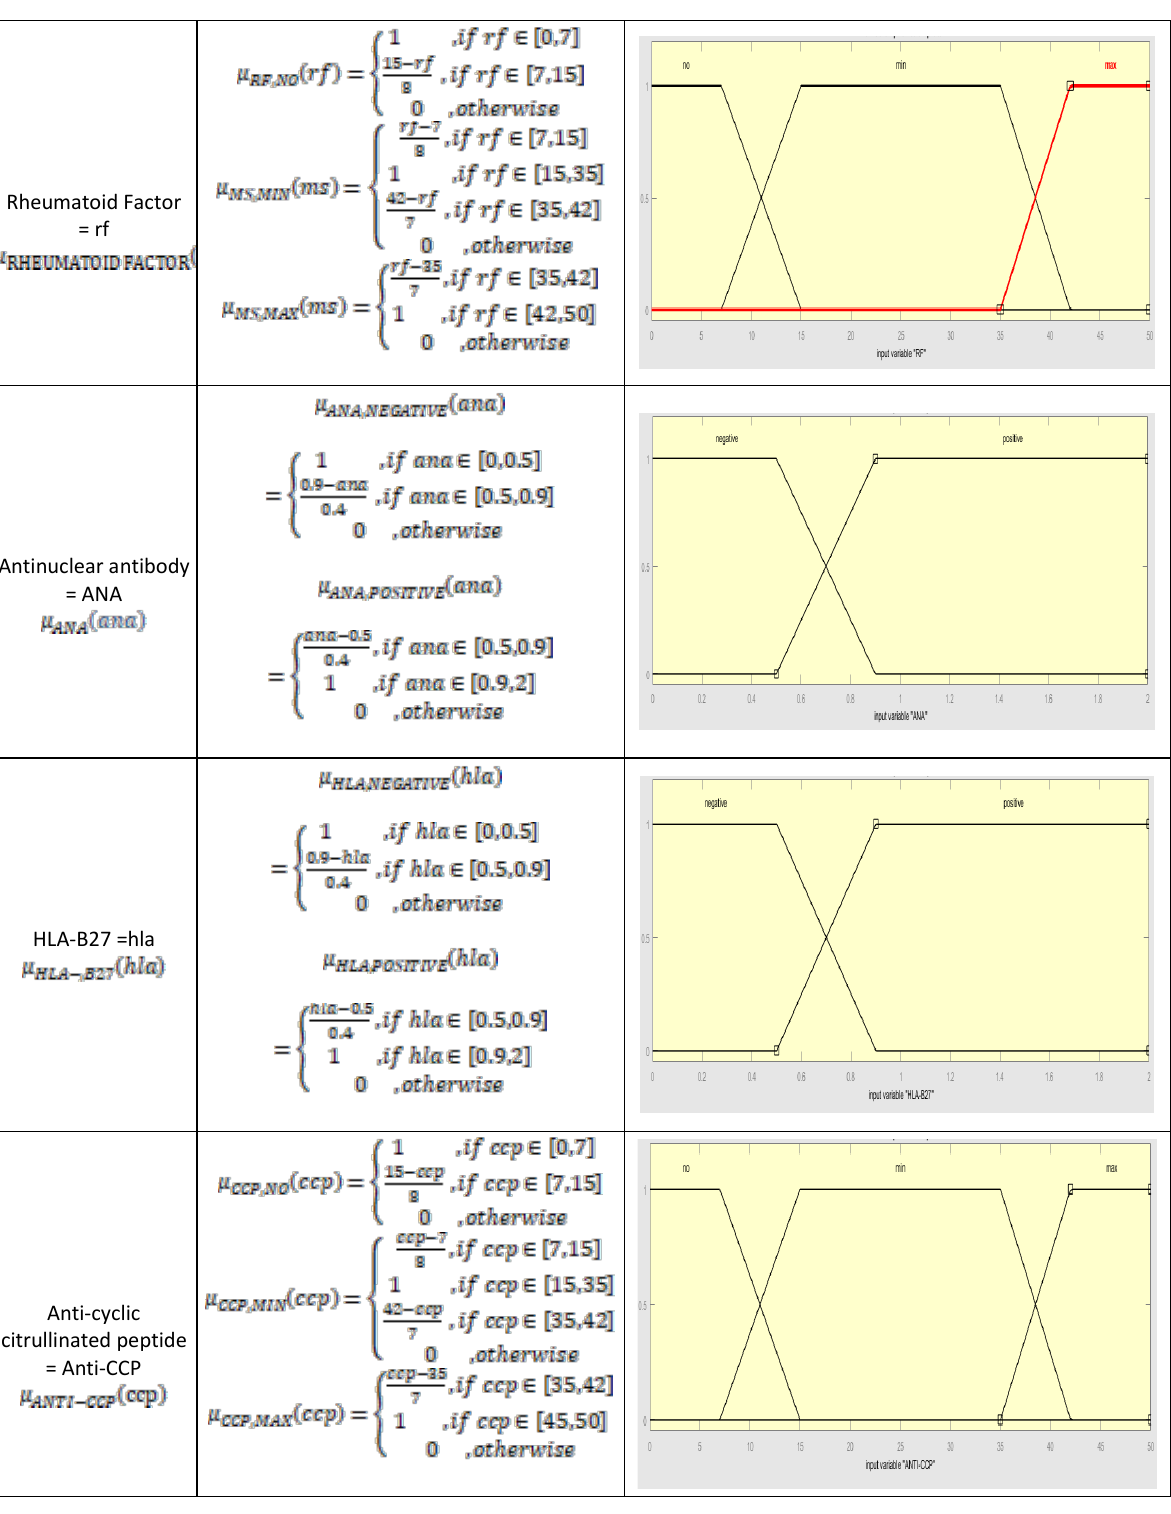
Table 6. Mat hematical & Graphical MF of Layer-1 & Layer-2 Mamdani Fuzzy Inference System Output